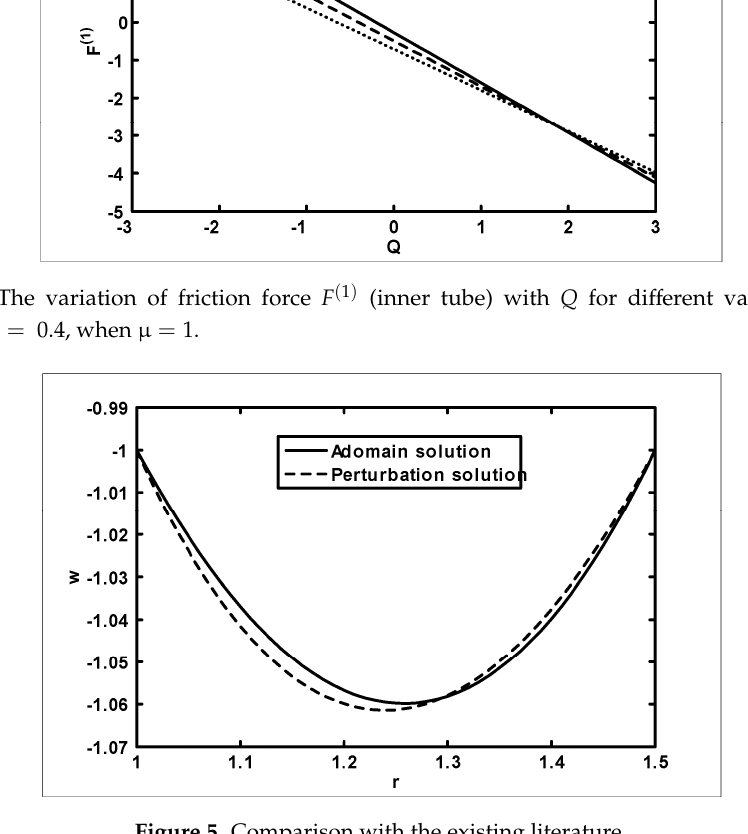
Coatings 2019 , 9 , x FOR PEER REVIEW Figure 5. Comparison with the existing literature. Figure 5. Comparison with the existing literature. Figure 5. Comparison with the existing literature.